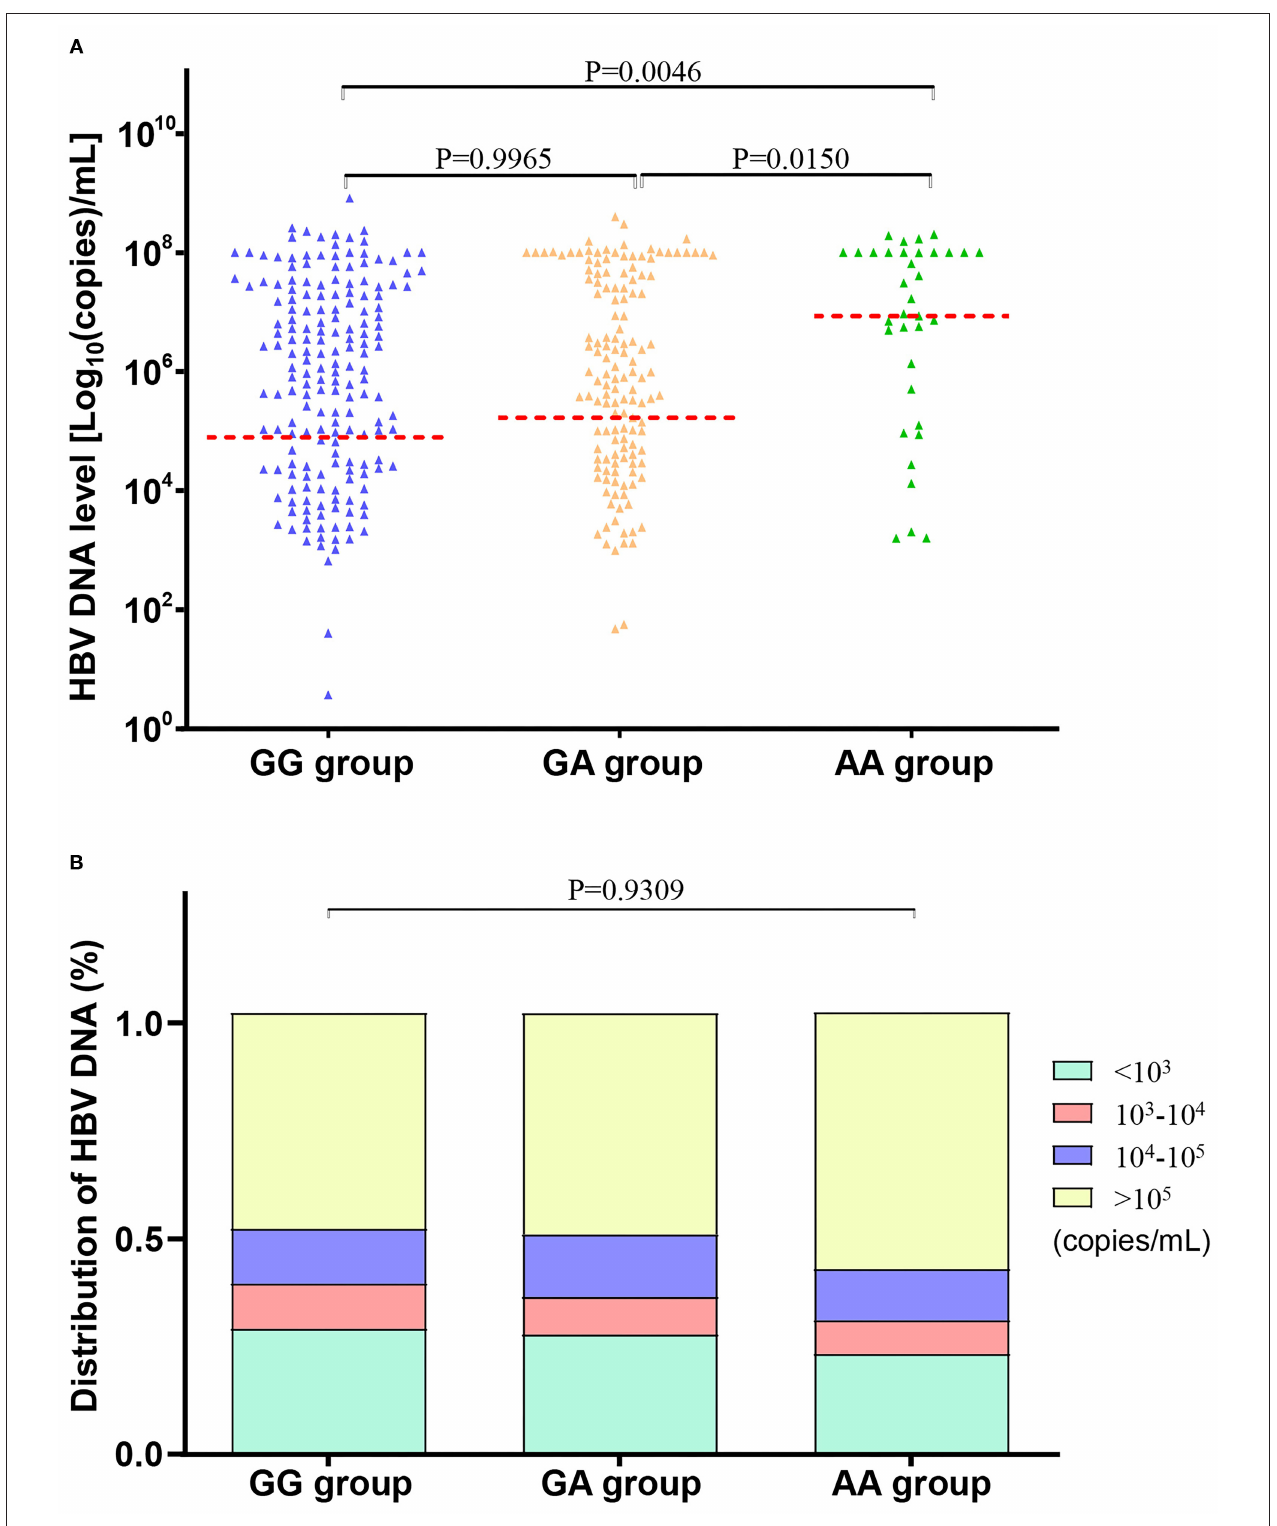
FIGURE 2 | HBV-DNA levels were the highest in patients with chronic hepatitis B (CHB) with rs671-AA genotype. (A) Comparison of HBV-DNA mean levels among subjects with AA, AG, and GG genotypes at rs671 in the CHB group. HBV-DNA levels were analyzed by converting to Log 10 (copies)/ml. Data were presented